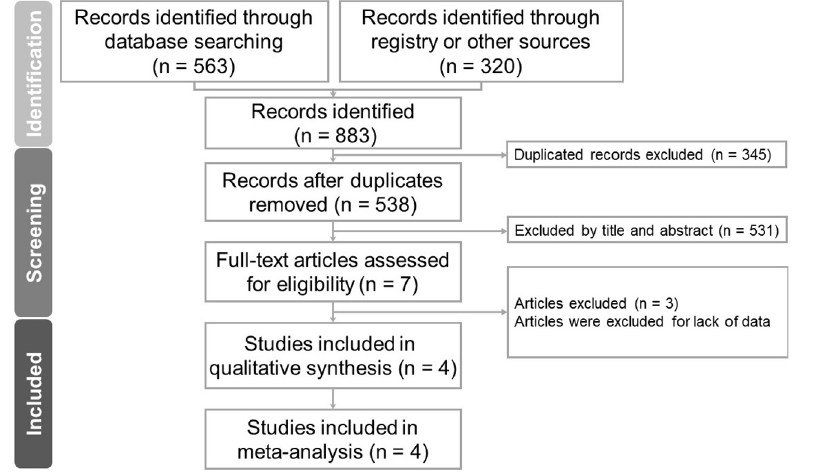
Fig 1. Flow chart for study